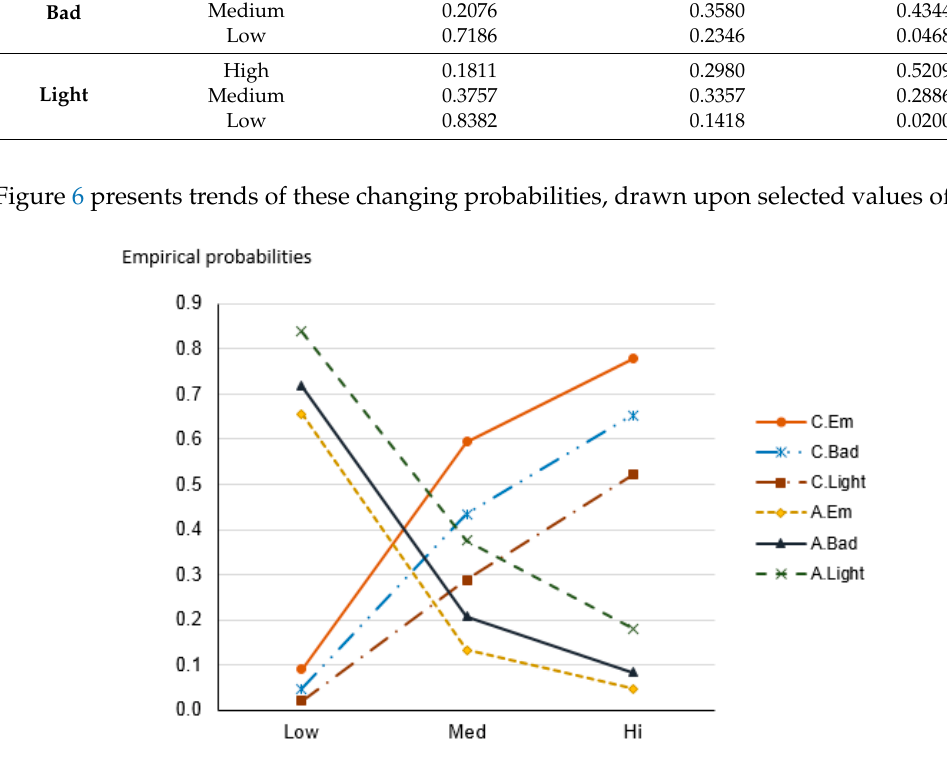
Figure 6. Contrasting risks as a function of illness and average cost of treatment. C—Destitute, A—Minimally affected; Em—Emergency; Bad—Bad ‐ illness; Light—Light ‐ illness.